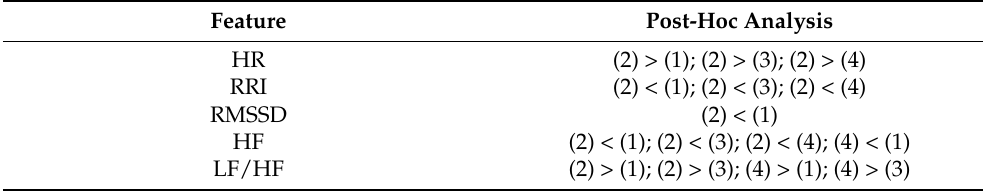
Table 5. Post hoc comparison for features with significant differences on the main